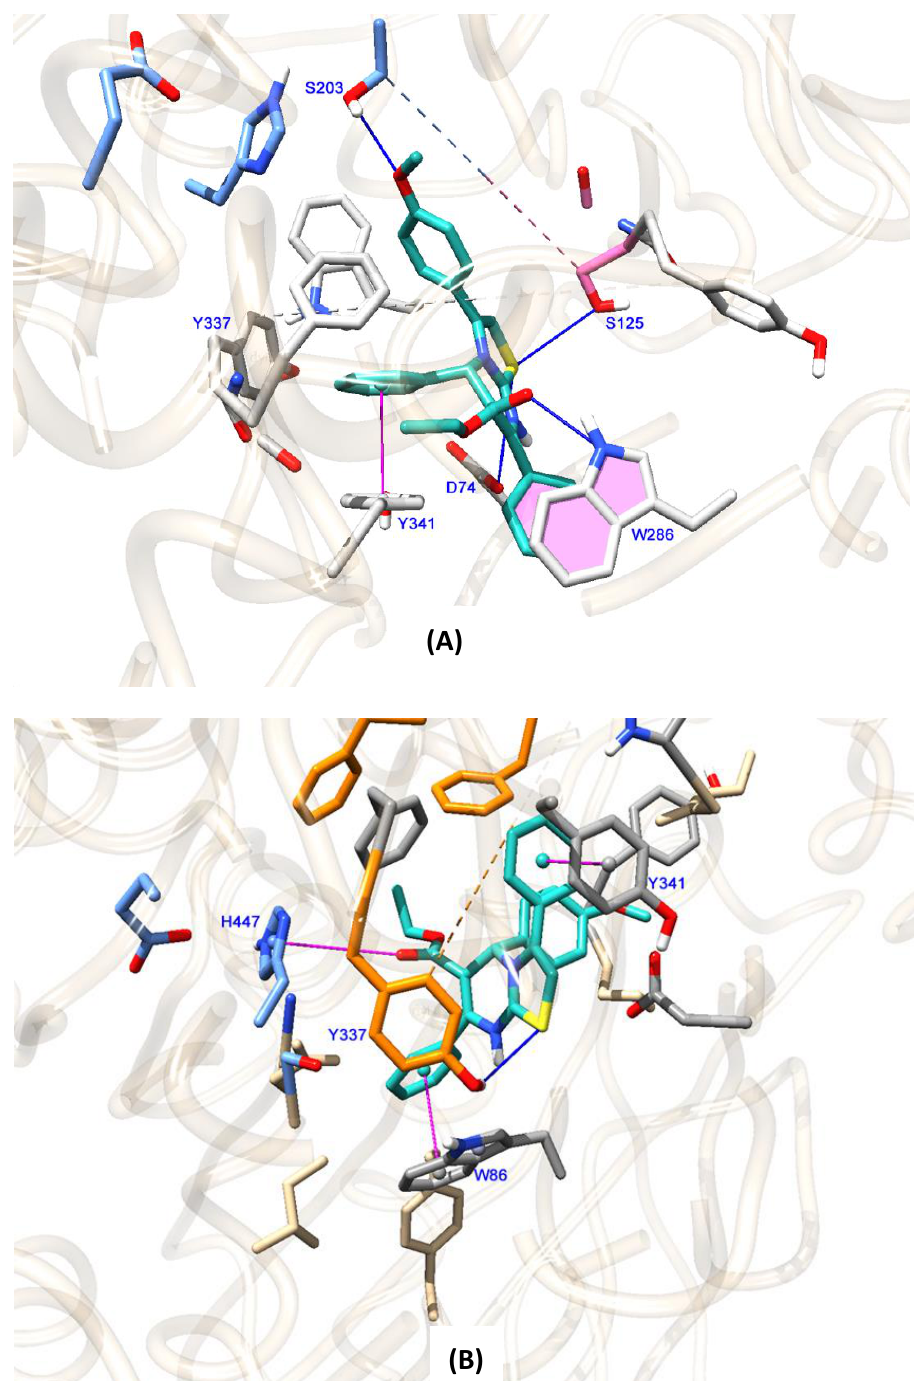
Figure 7. ( A ) and ( B ) A close view of 7b and 7d docked into the active site gorge of human AChE. Catalytic residues are shown in blue and the peripheral anionic site residues are shown in grey; the ligands are shown in light blue.